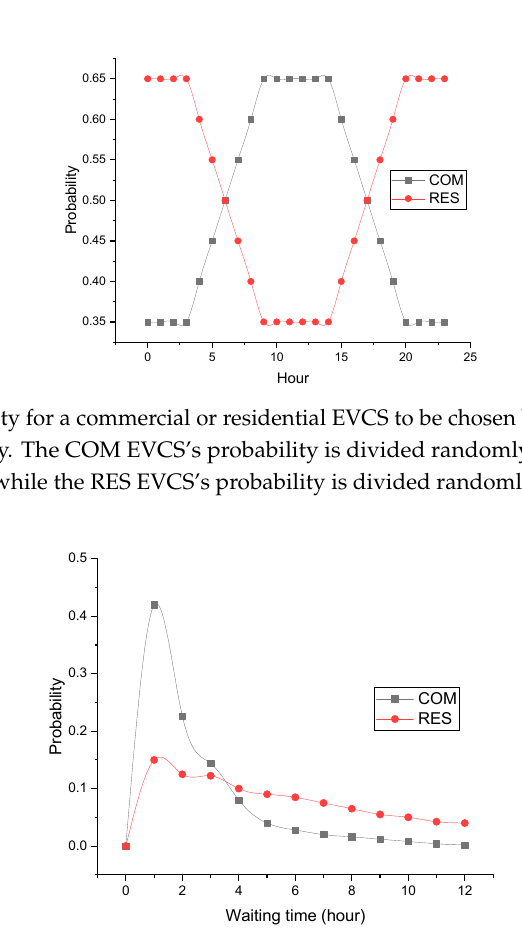
Figure 2. The probability of the time that each EV will spend as the waiting/parking time to get charged at each type of the EVCSs.